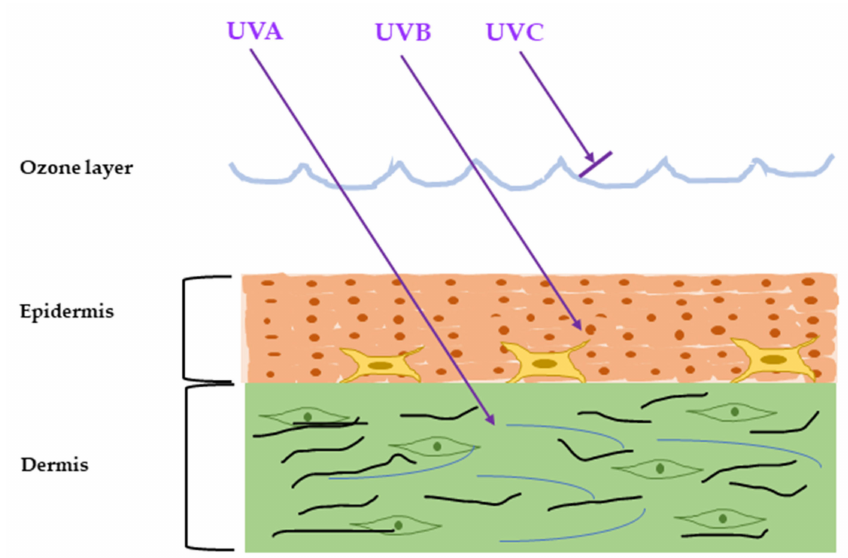
Figure 1. Penetration of the solar ultraviolet radiation (UVR) into the skin. According to the wavelength, the UVR is classified into three categories: UVA, UVB, and UVC. UVC is blocked by the ozone layer, UVB can penetrate into the epidermis, and UVA can penetrate up to the